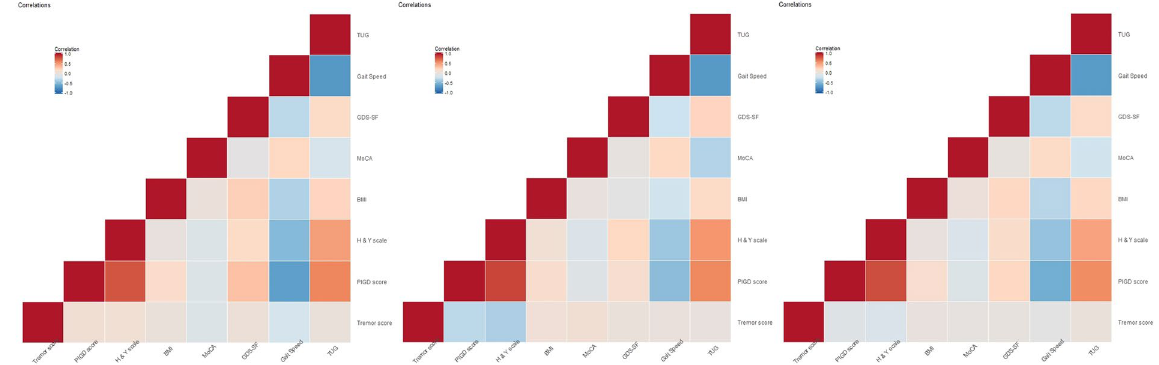
Figure 2. Pair correlations of some features, separately for each of the three datasets used in the study. ( A ) Michigan data boxplots illustrating significant differences in MDS_TREM (p = 0.5465), MDS_PIGD (p < 0.001), H and Y scale (p < 0.001), gaitSpeed_Off (p < 0.001) between PD patients with and without a history of falls, based on MWW test. (No = 0, Yes = 1). ( B ) Tel-Aviv data boxplots illustrating significant differences in Tremor_score (p = 0.01094), PIGD_score (p < 0.001), H and Y scale (p < 0.001) and FOG_Q (p < 0.001) between PD patients with and without a history of falls, based on MWW test. (No = 0, Yes = 1).